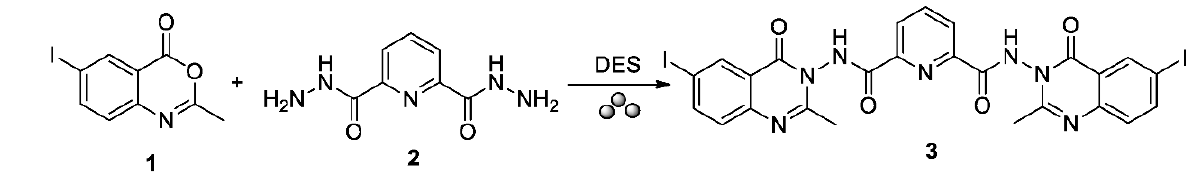
Figure 2. Synthesis of pyridine-2,6-dicarbohydrazide.